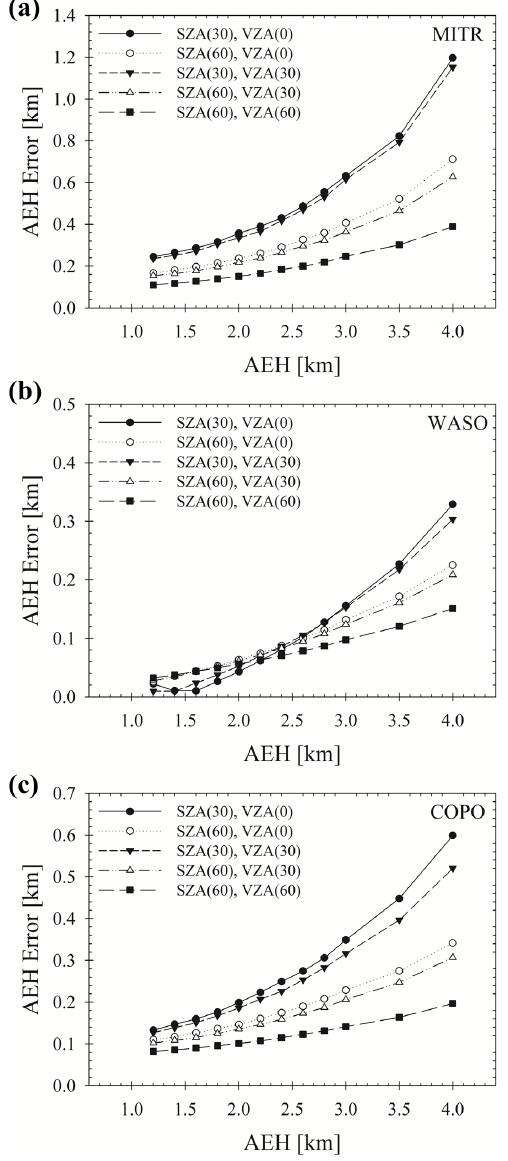
Figure 8. AEH error of (a) MITR, (b) WASO, and (c) COPO for the AOD difference of 0.1 as changing viewing geometries.